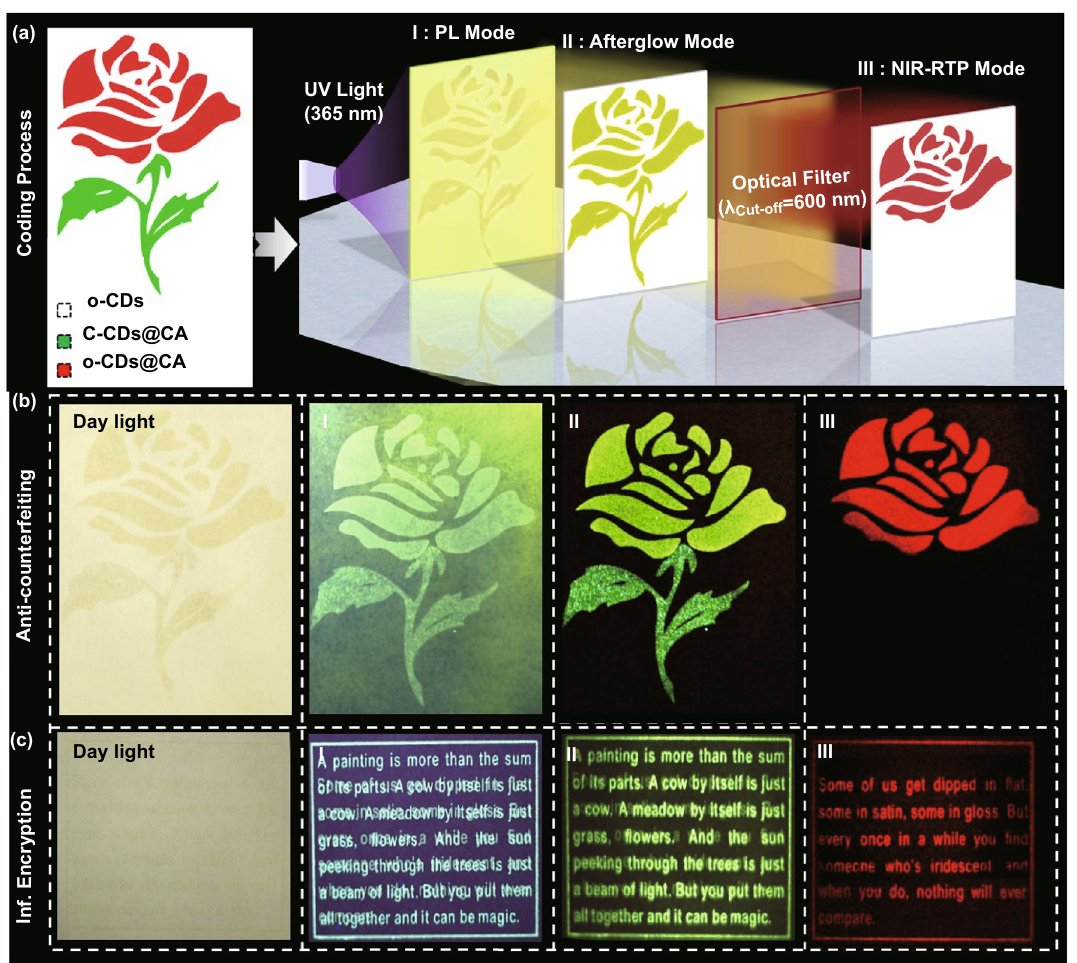
Fig. 4 a Schematic illustration of the encryption and decryption procedure using the o-CDs@CA in information security applications. The o-CDs are directly dying on the filter paper, the o-CDs@CA and C-CDs@CA are dispersed in commercial ink and fabricated onto the filter paper by silk-screen printing); b‑c the images of the interference patterns (I–II) (under PL and afterglow modes) and decrypted pattern (III) (afterglow mode with the using of an optical filter (λ Cut-off = 600 nm)) for anti-counterfeiting b and information (Inf.) encryption